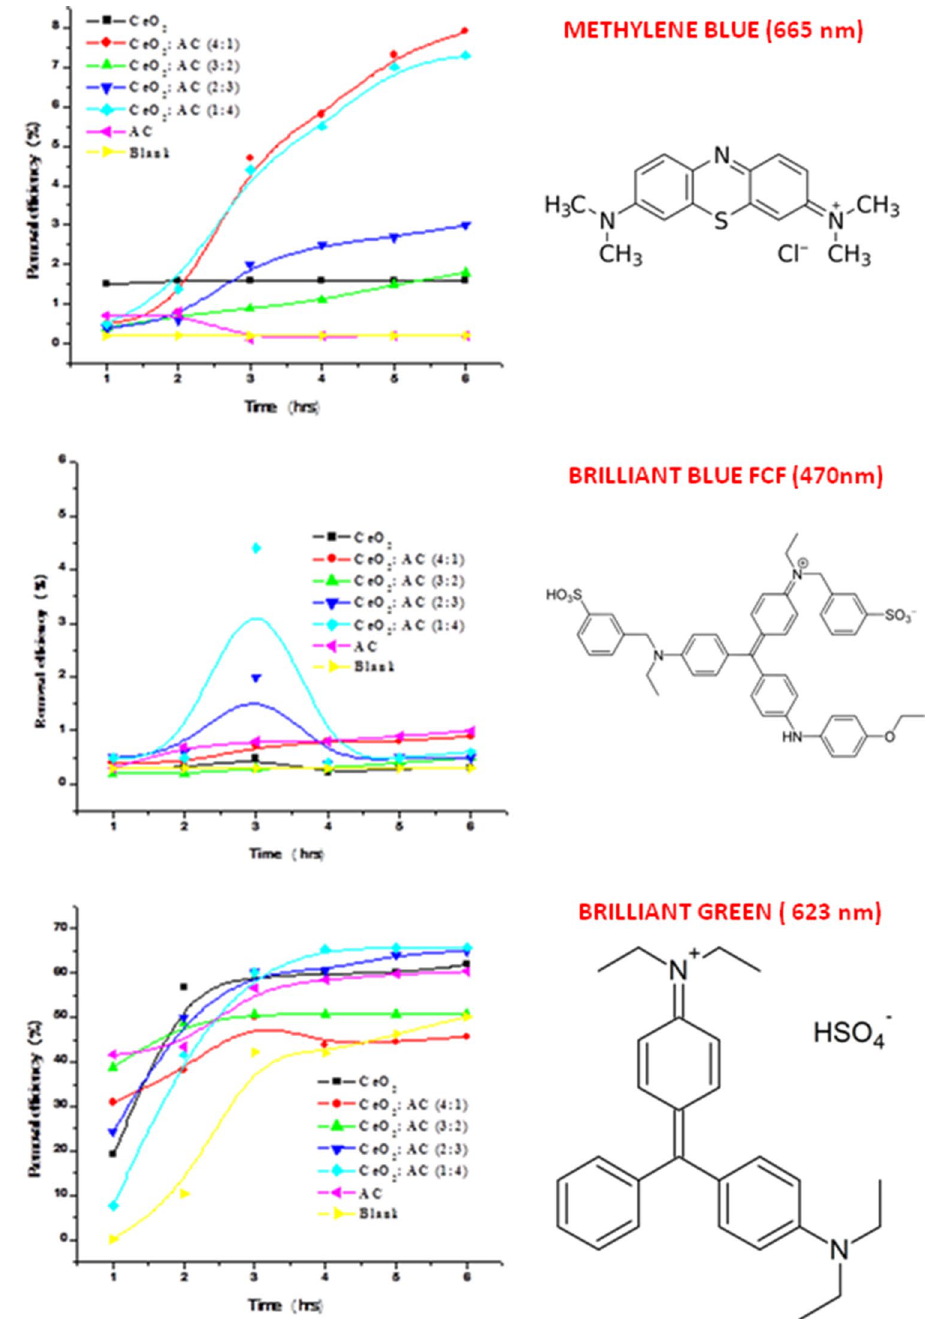
Fig. 7 Photocatalytic degrada- tion of industrial dyes using CeO 2 /AC